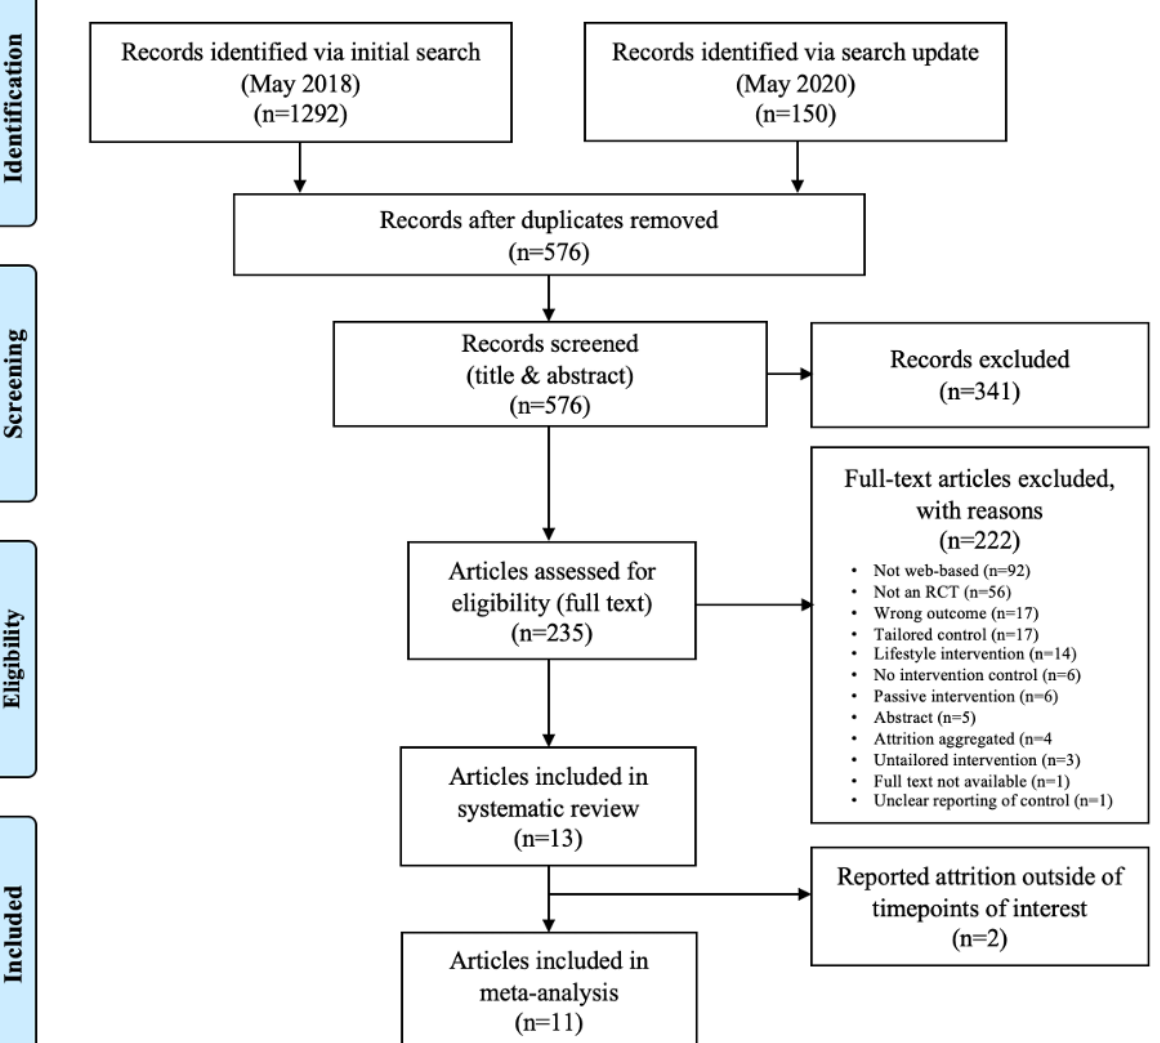
Figure 1. PRISMA (Preferred Reporting Items for Systematic reviews and Meta-Analyses) diagram.